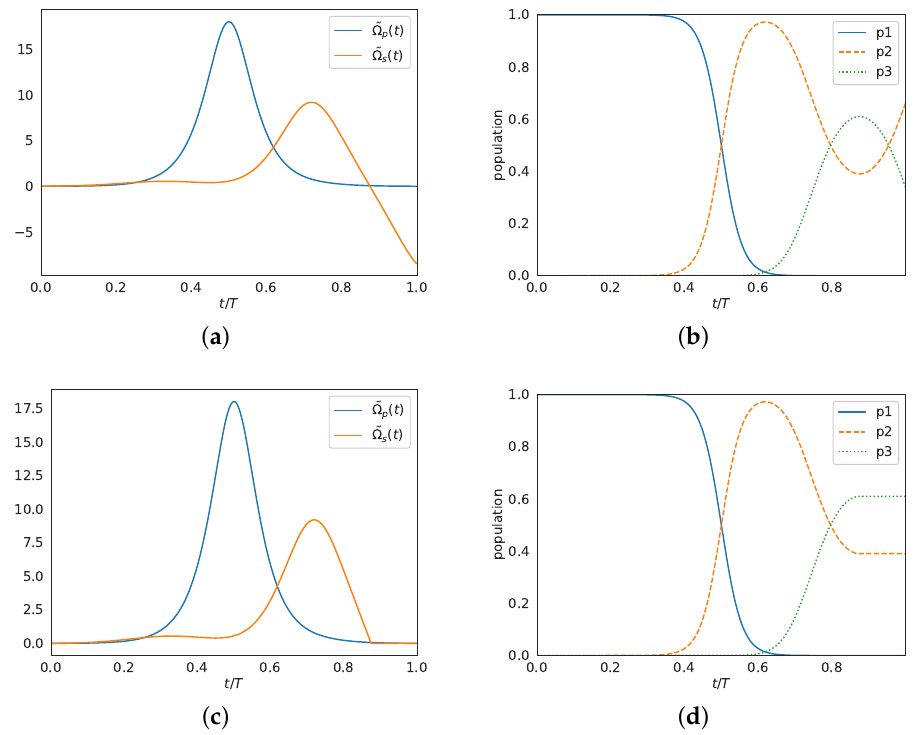
Figure 5. ( a ) Pump and Stokes pulses (in units T − 1 ) for the shortcut derived from Gaussian pulses with Ω = 0.5 T − 1 . ( b ) Corresponding time evolution of the level populations. ( c , d ) Controls (in units T − 1 ) 0 and populations for the modified shortcut where the final negative part of the Stokes pulse is